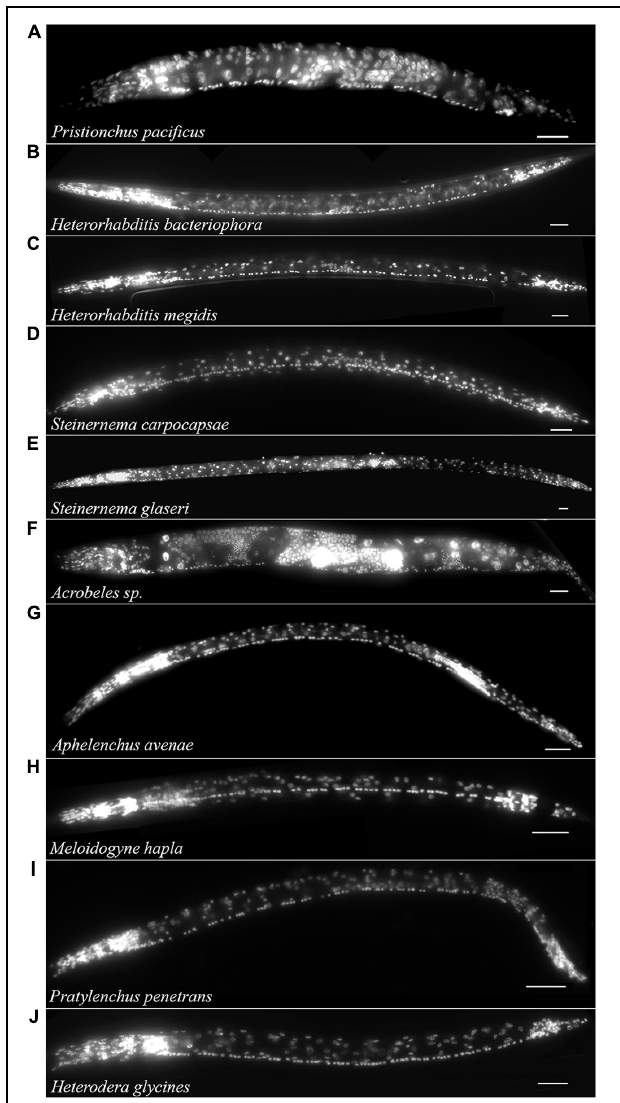
FIGURE 3 | The VNC of nematodes in Clades 8–12 is highly variable. Fluorescent micrographs of individual nematode species fixed in formaldehyde and exposed to DAPI followed by imaging under fluorescent light. Species examined include: (A) Pristionchus pacificus hermaphrodite (Clade 9). (B) Heterorhabditis bacteriophora infective juvenile (Clade 9). (C) Heterorhabditis megidis infective juvenile (Clade 9). (D) Steinernema carpocapsae infective juvenile (Clade 10). (E) Steinernema glaseri infective juvenile (Clade 10). (F) Acrobeles sp. adult female (Clade 11). (G) Aphelenchus avenae J3 (Clade 12). (H) Meloidogyne hapla J2 (Clade 12). (I) Pratylenchus penetrans adult female (Clade 12). (J) Heterodera glycines J2 (Clade 12). Scale bar = 20 µ